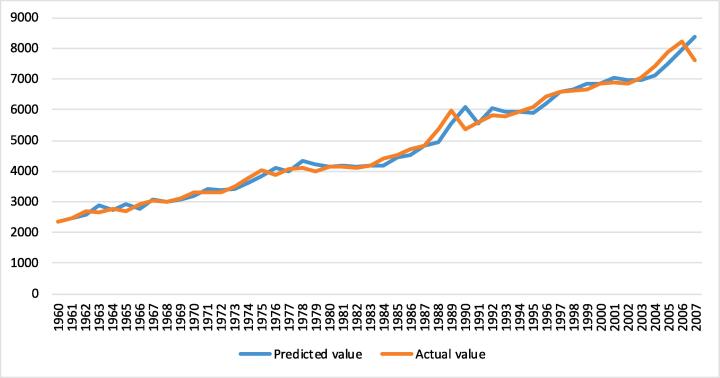
Validity of the ARIMA model of area prediction.